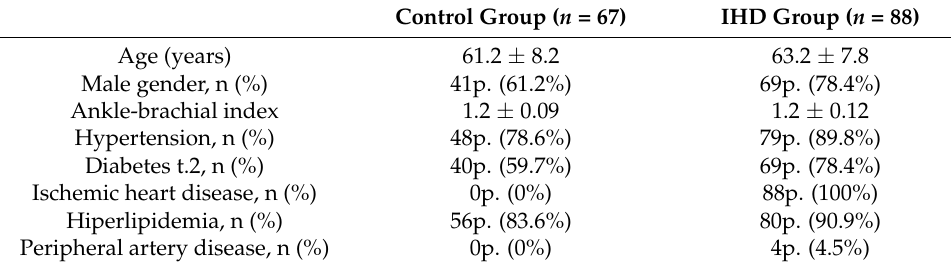
Table 1. The general characteristics of the control and IHD